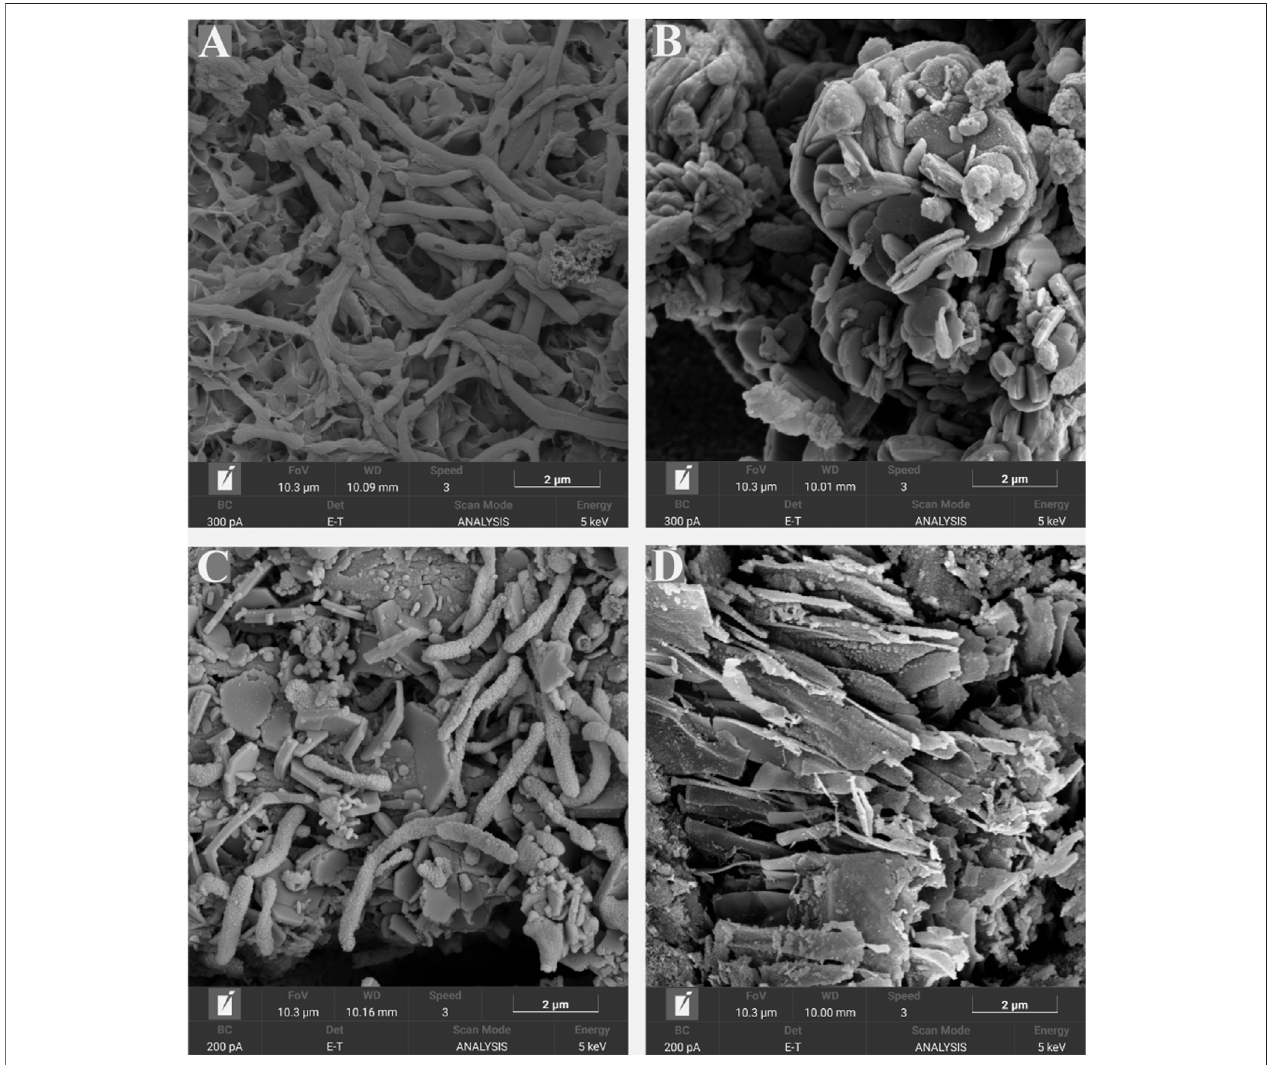
FIGURE 7 | SEM micrographs of coupon ’ s surfaces after 16-days exposure to S. chilikensis under thiosulphate reducing conditions (A) and nitrate reducing conditions (C) . (B,D) correspond to their respective sterile controls.